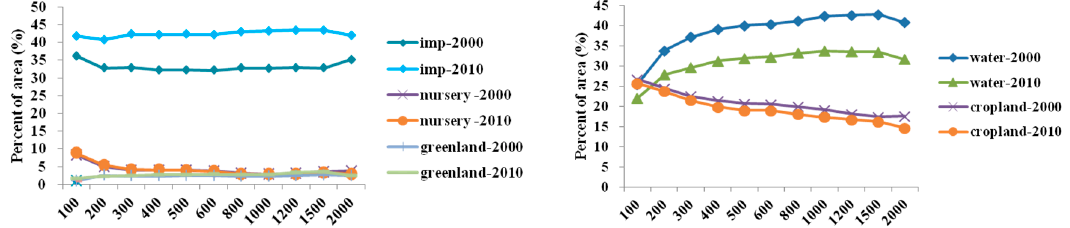
Figure A1. Mean value of land use characteristics of the river section within the buffer of 100 m–2000 m in 2000 and 2010.